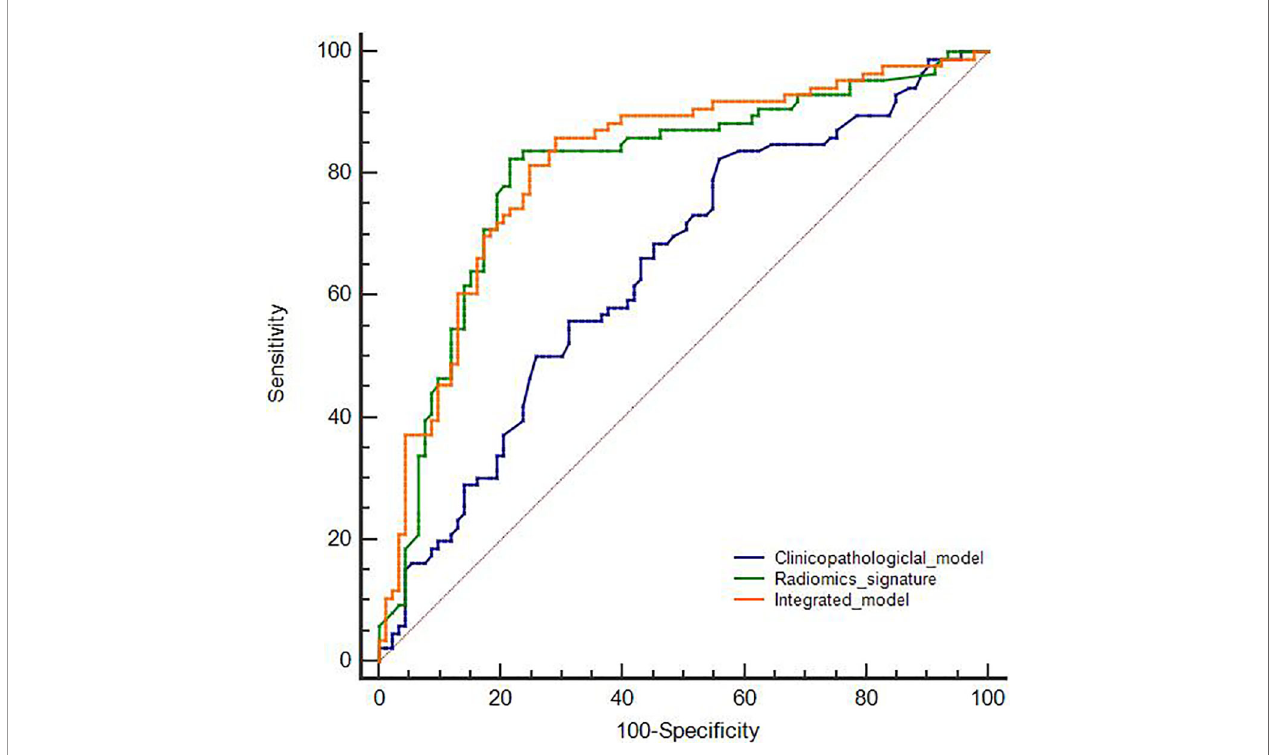
FIGURE 2 | Receiver operating characteristic curves of the developed models in the training cohort.